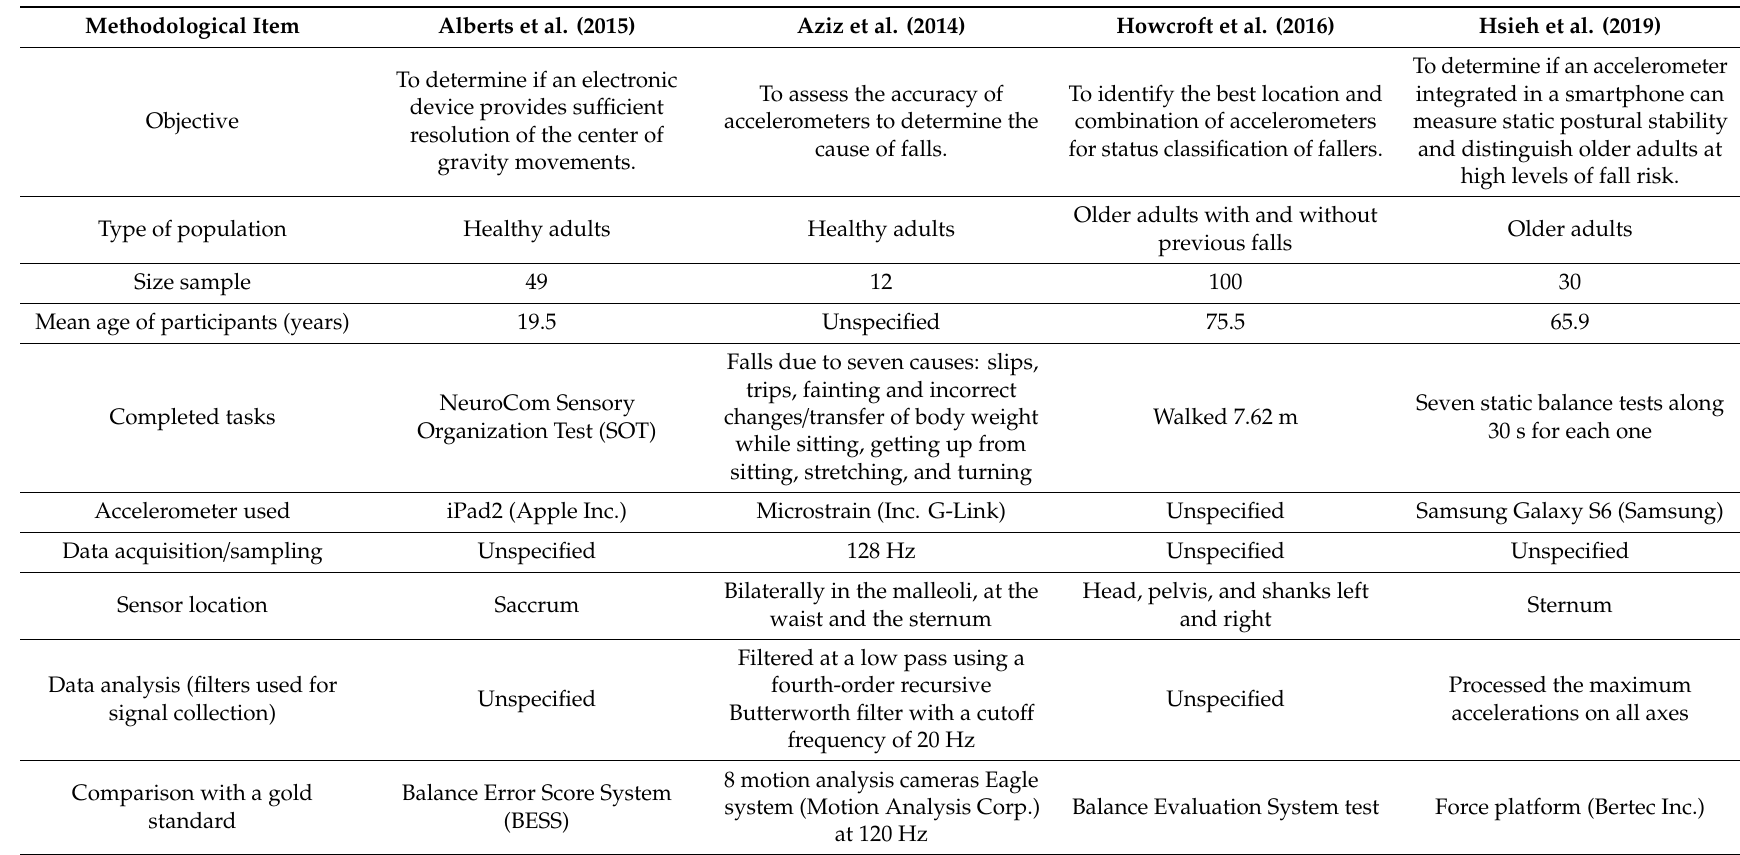
Table A4. Methodological details of the research